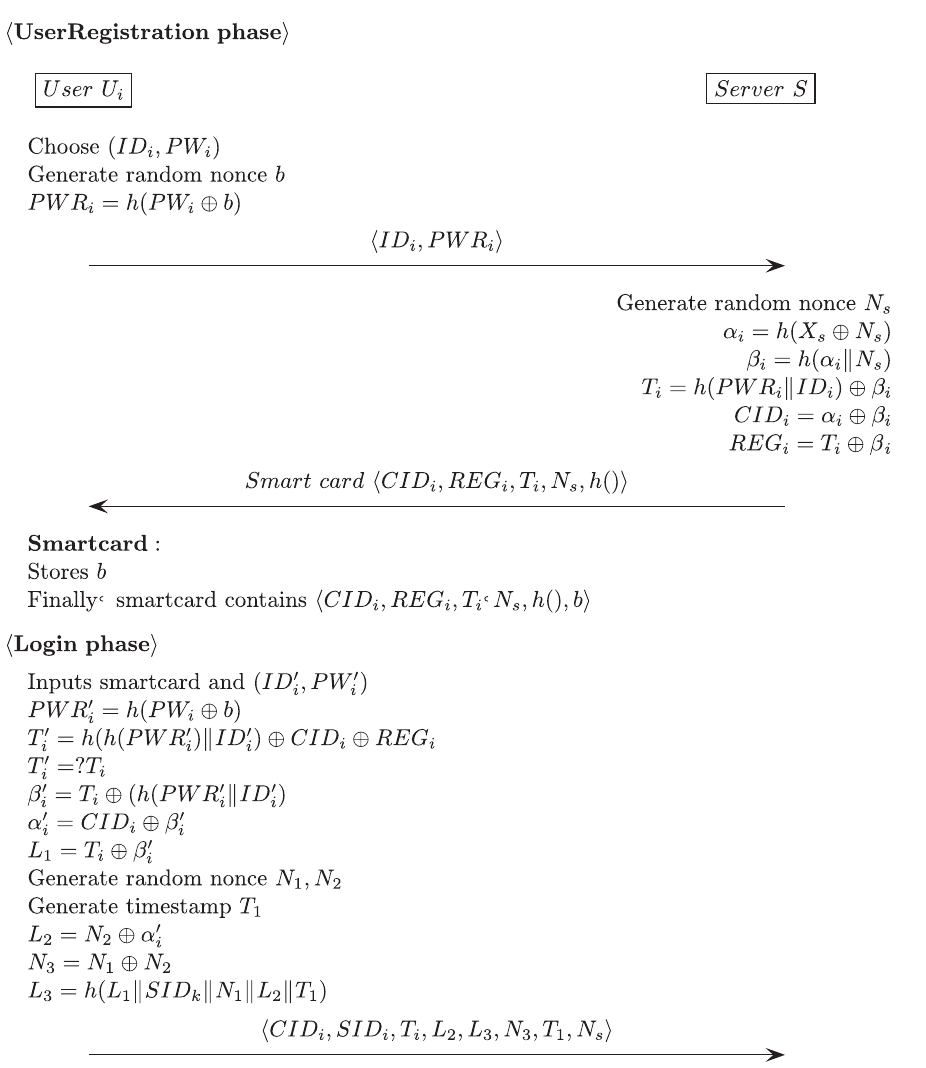
Fig 3. Example of user non-traceability not being